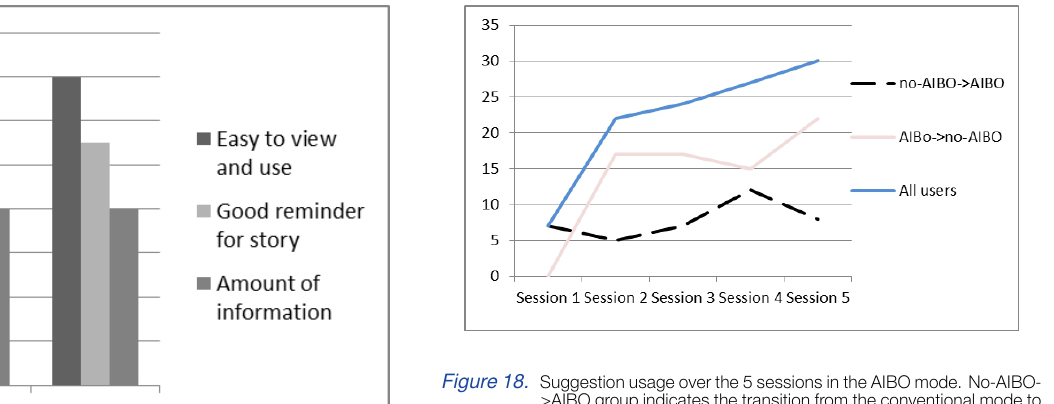
Figure 18. Suggestion usage over the 5 sessions in the AIBO mode. No-AIBO- >AIBO group indicates the transition from the conventional mode to the robot mode while AIBO->no-AIBO reflects the